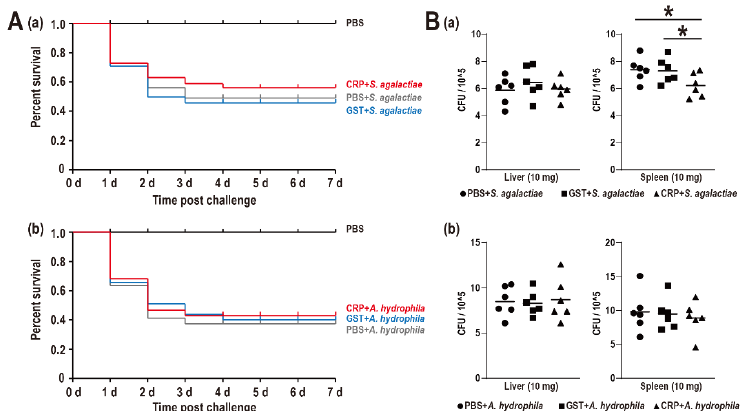
Figure 4. ( A ) Survival rates of Nile tilapia after S. agalactiae ( a ) and A. hydrophila ( b ) infection. Daily statistical mortality was calculated for 7 days, n = 50 for each group. 100 µL PBS for PBS group, S. agalactiae (5 × 10 7 CFU/mL) dissolved in 100 µL PBS for S. agalactiae + PBS group, S. agalactiae (5 × 10 7 CFU/mL) with GST-tag protein (4 nmol)/rGST-On-CRP (4 nmol) dissolved in the 100 µL PBS for S. agalactiae + GST group/ S. agalactiae +CRP group. The parallel processing was also performed among three A. hydrophila challenge groups with 100 µL A. hydrophila (5 × 10 7 CFU/mL). ( B ) Bacterial burden in liver and spleen of Nile tilapia post S. agalactiae ( a ) and A. hydrophila ( b ) infection at 48 h. All values are the mean ± SD; n = 6. Significant difference is indicated by asterisks ( p < 0.05).